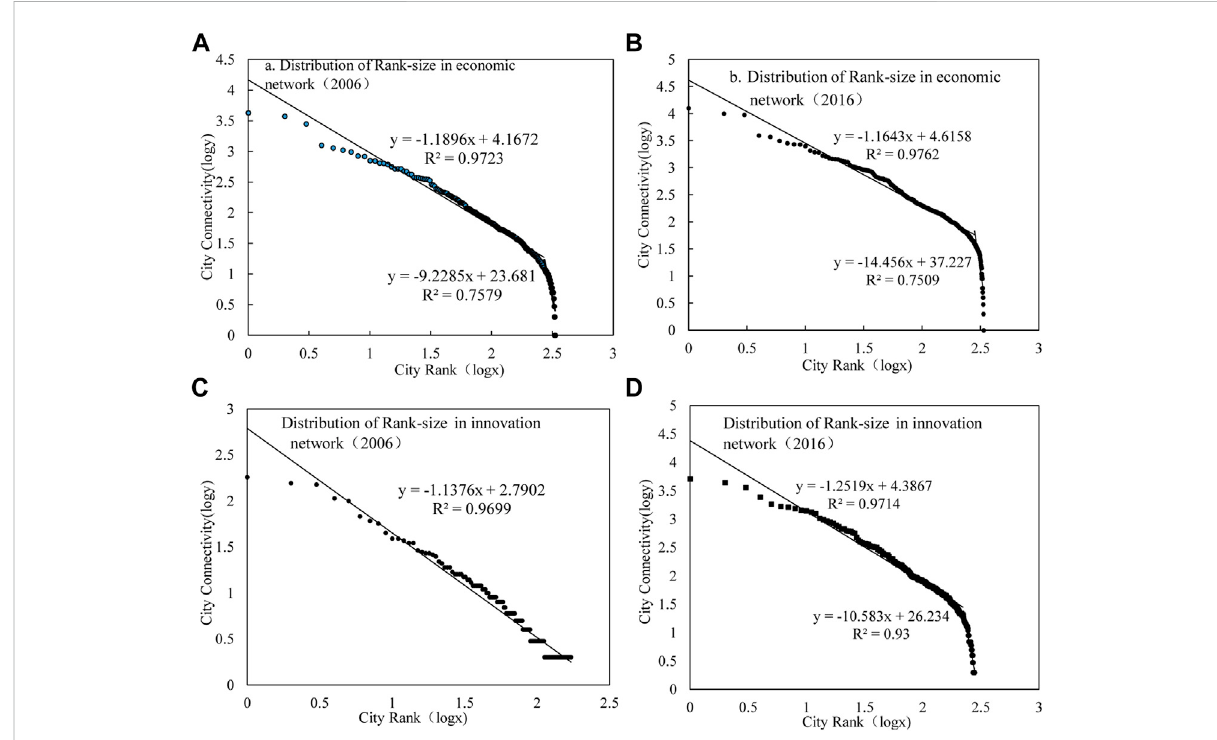
FIGURE 5 Rank-size distribution of city connectivity in the economic network and innovation